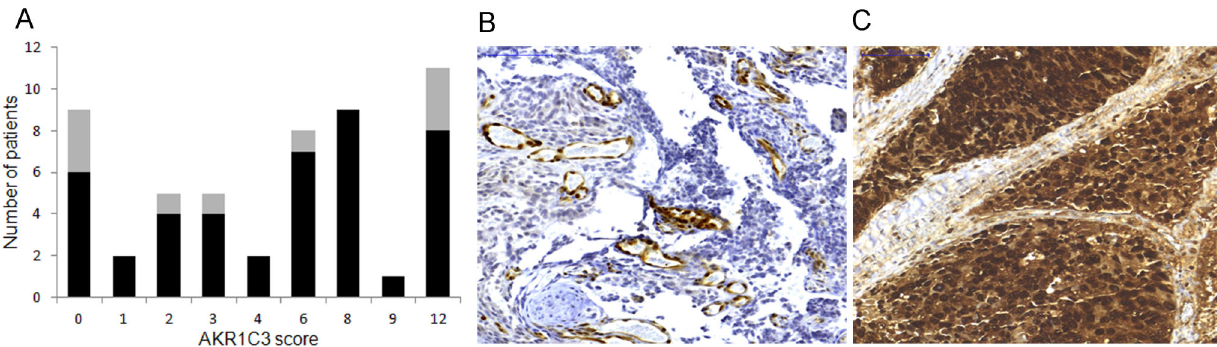
Figure 3. Immunohistochemical staining of AKR1C3 in bone metastases. A total score (ranging from 0–12) was obtained by multiplying the staining intensity score (0–3) in the tumor epithelial cells with the positive fraction score (1–4). (a) Histogram according to total AKR1C3 staining score in hormone-naı¨ve (gray) and castration-resistant (black) bone metastases. (b) Representative section of bone metastasis with AKR1C3 total score 0. (c) Representative section of bone metastasis with AKR1C3 total score 12. Bar indicates 100 m M.